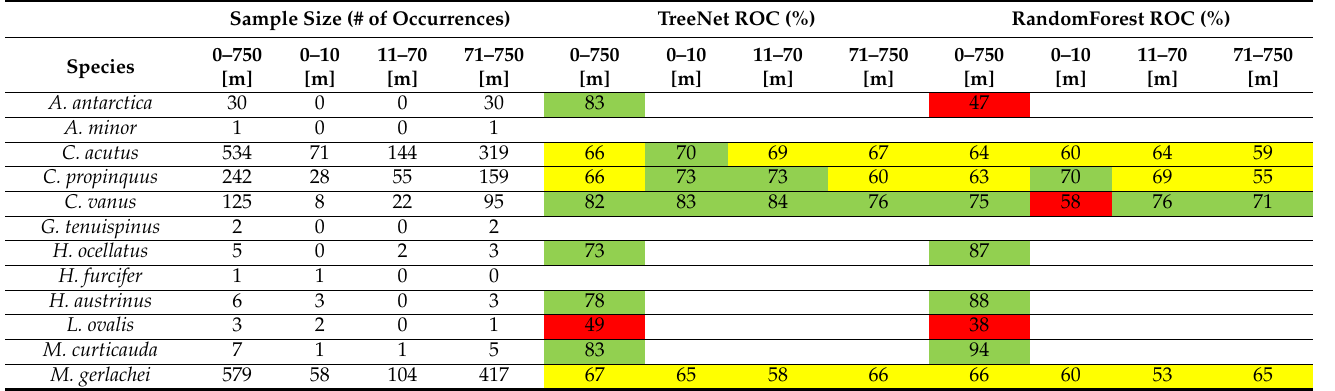
Table 3. Species list with sample size and ROC accuracy for both models: Red (poor), yellow (good), and green (very